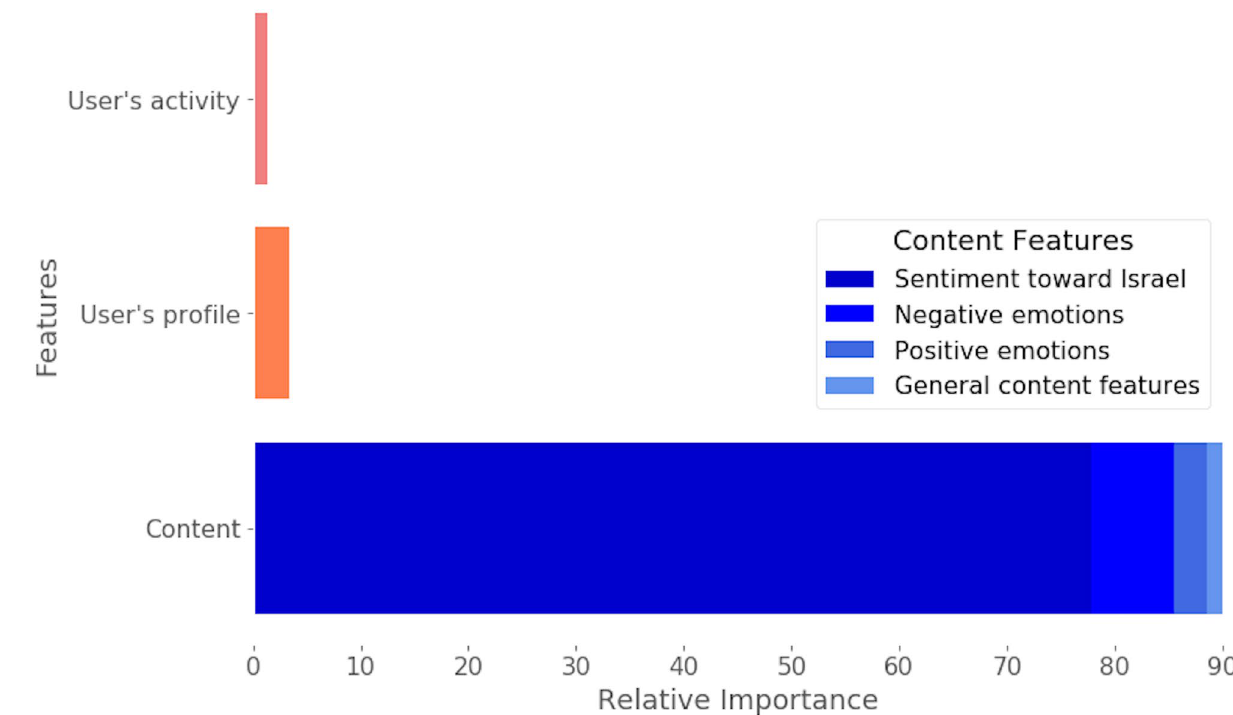
Figure 1. Aggregated feature importance of the O.I. prediction model. Relative importance was calculated by averaging the decrease in impurity over trees, considering the interaction between all the features. Aggregated features are subdivided into content, user profile, and previous user activity. Data shown were generated using the Random Forest